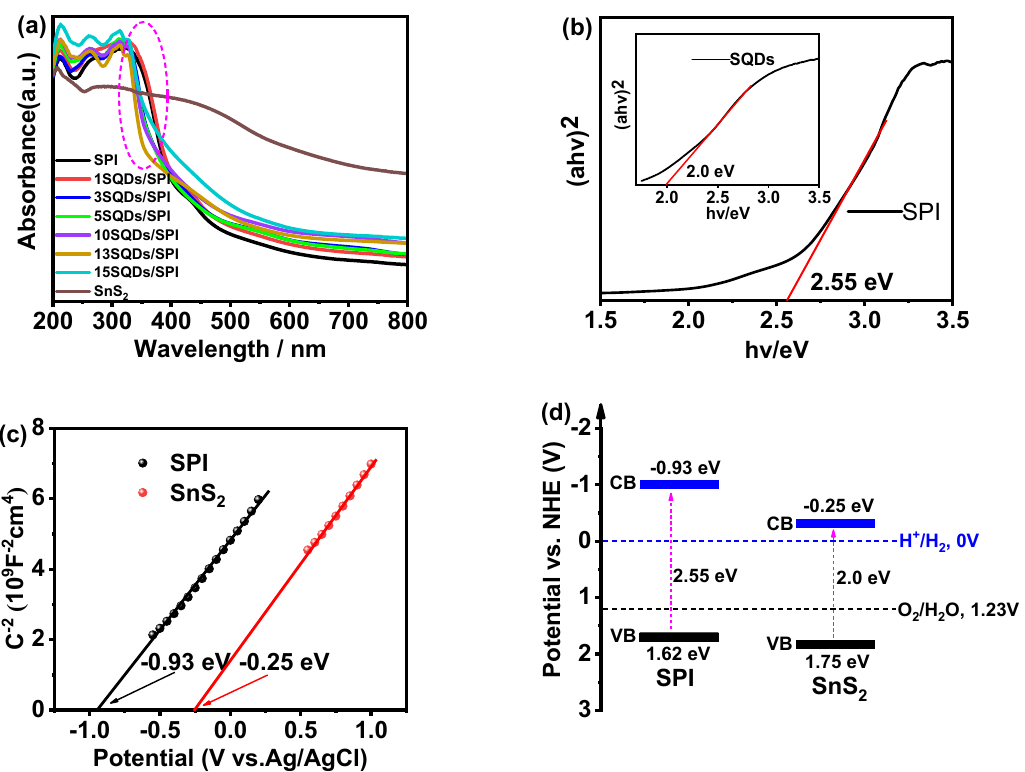
Figure 5. ( a ) UV–vis DRS spectra of SPI, SQDs, and SQDs/SPI samples. ( b ) The corresponding plots of ( α h ν ) 2 versus h ν of SPI and SQDs. ( c ) Mott–Schottky plots of SPI and SQDs. ( d ) Schematic illustration of band structures for SPI and SQDs.